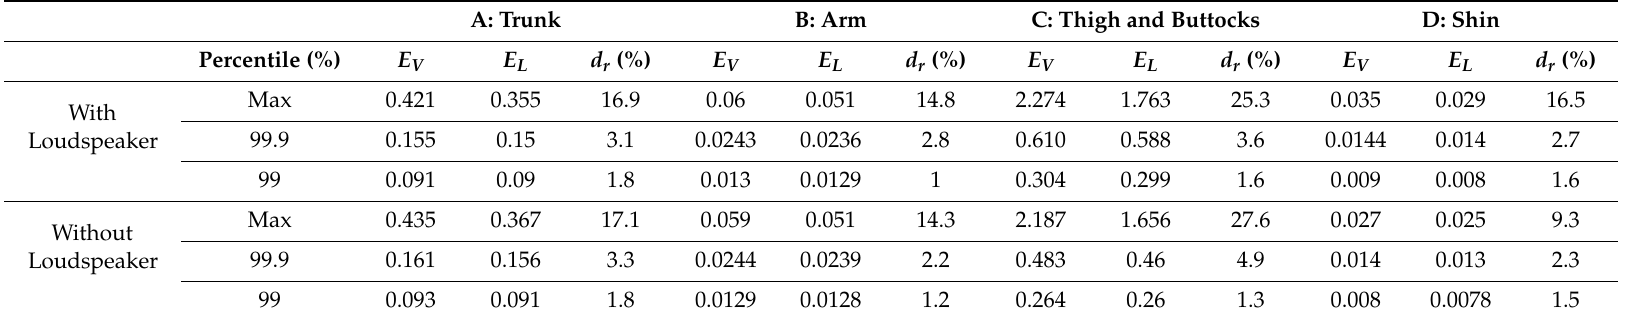
Table 3. Averaging values of in situ electric field strength (V / m) in di ff erent driver model measurement positions with and without the loudspeakers (both woofer and tweeter) in the CFRP vehicle.